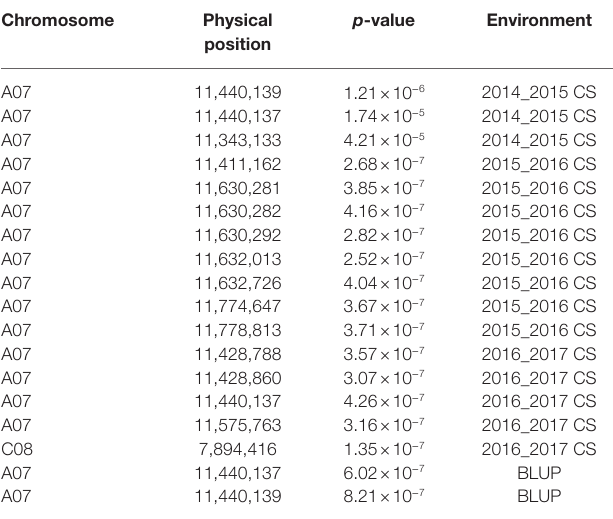
TABLE 3 | SNP position with significant association for SOC in MLM of EMMAX. Chromosome Physical p -value position